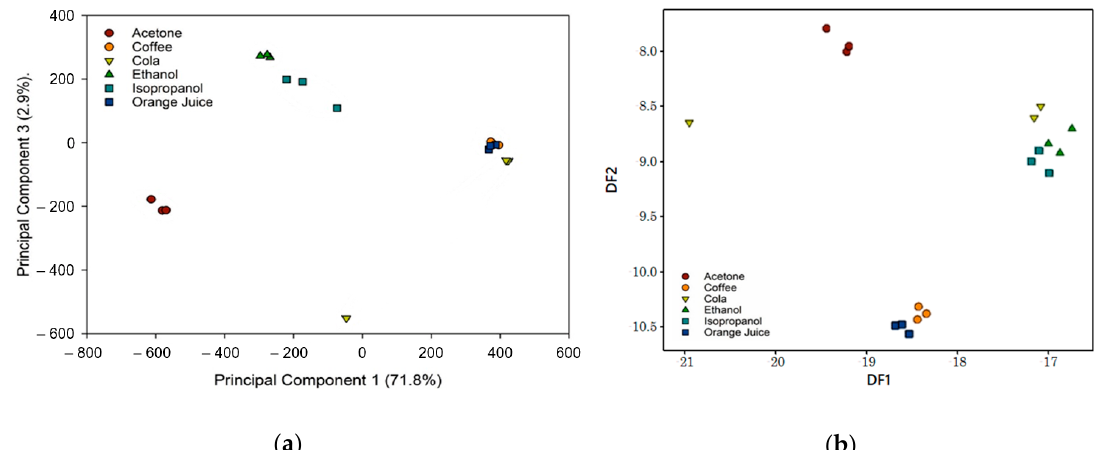
Figure 14. Classification analysis for testing of chemical standards and complex mixtures: ( a ) principal component analysis; and ( b ) linear discriminant analysis (DF—Discriminant Function).